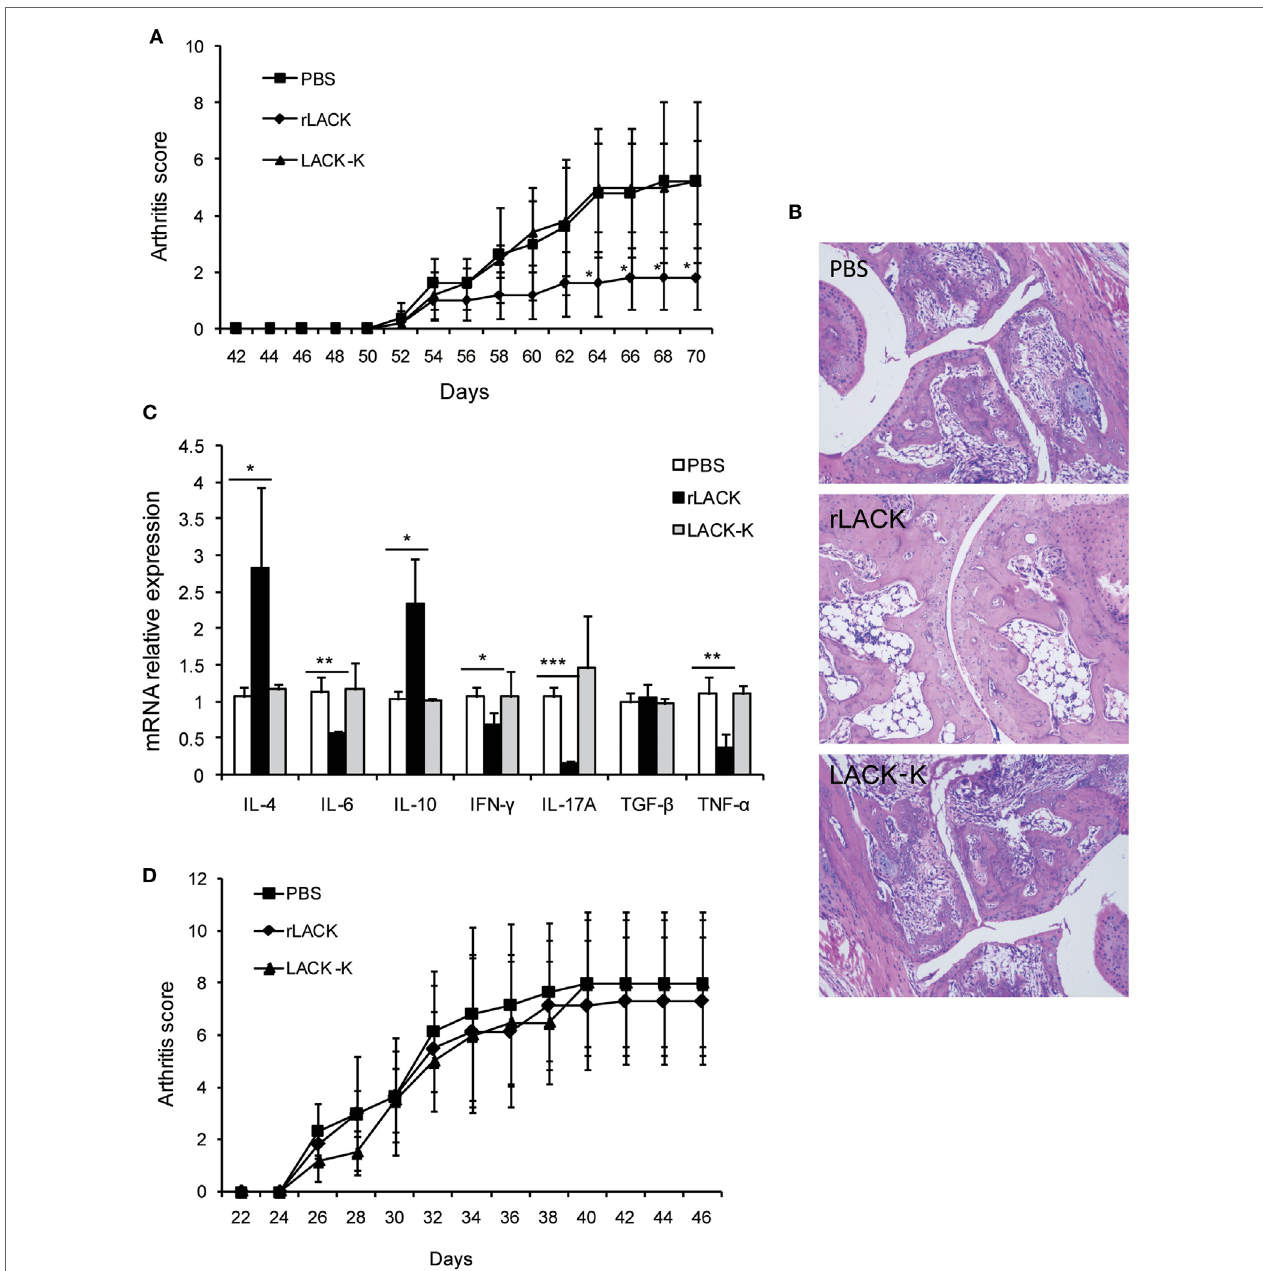
FigUre 2 | The effect of the LACK 156–173 epitope in other animal models of autoimmune arthritis. Proteoglycan (PG)-induced arthritis (PGIA) mice were treated with PBS/rLACK/LACK-K (50 µg) after the third injection of PG with 7-day interval. Collagen-induced arthritis (CIA) mice were treated with PBS/rLACK/LACK-K (50 µg) after the booster injection with 7-day interval. (a,B) The severity of arthritis was evaluated by arthritis scoring (a) and joint histopathology (B) in PGIA mice. Original magnification, 100 × . (c) Cytokine gene expression in the knee synovium of PGIA mice was analyzed on day 70. (D) The effect of LACK 156–173 epitope treatment on the arthritis scores of CIA mice. The data are expressed as the mean ± SEM for eight animals in each group, combined from at least three independent experiments. * p < 0.05, ** p < 0.01, *** p <